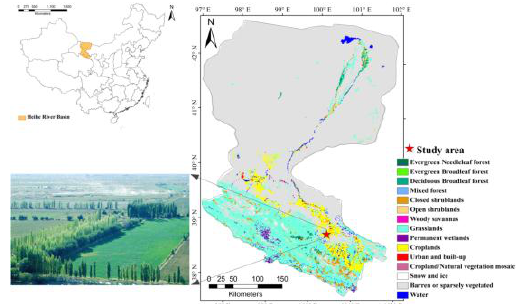
Figure 1. The location of the study area in the middle reaches of the Heihe River Basin.